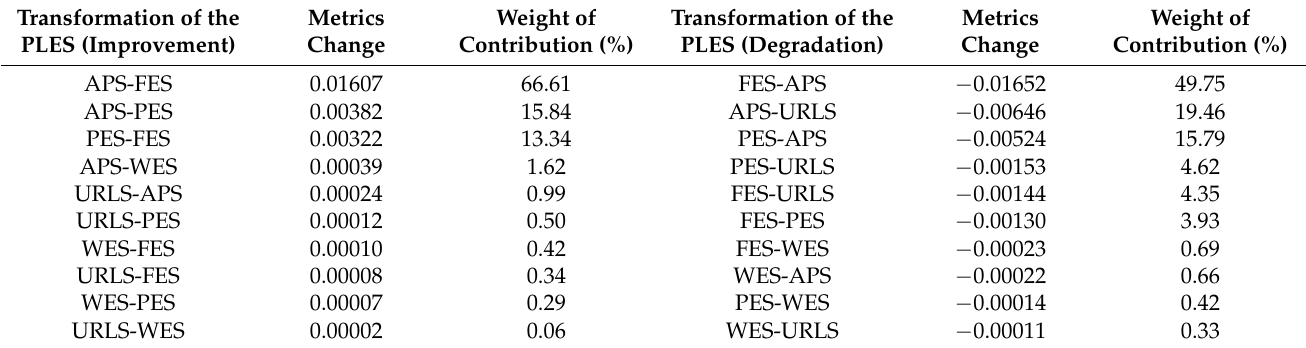
Table 6. Contribution of PLES transfer to effects on ecological environmental quality in the TGRR from 2000 to